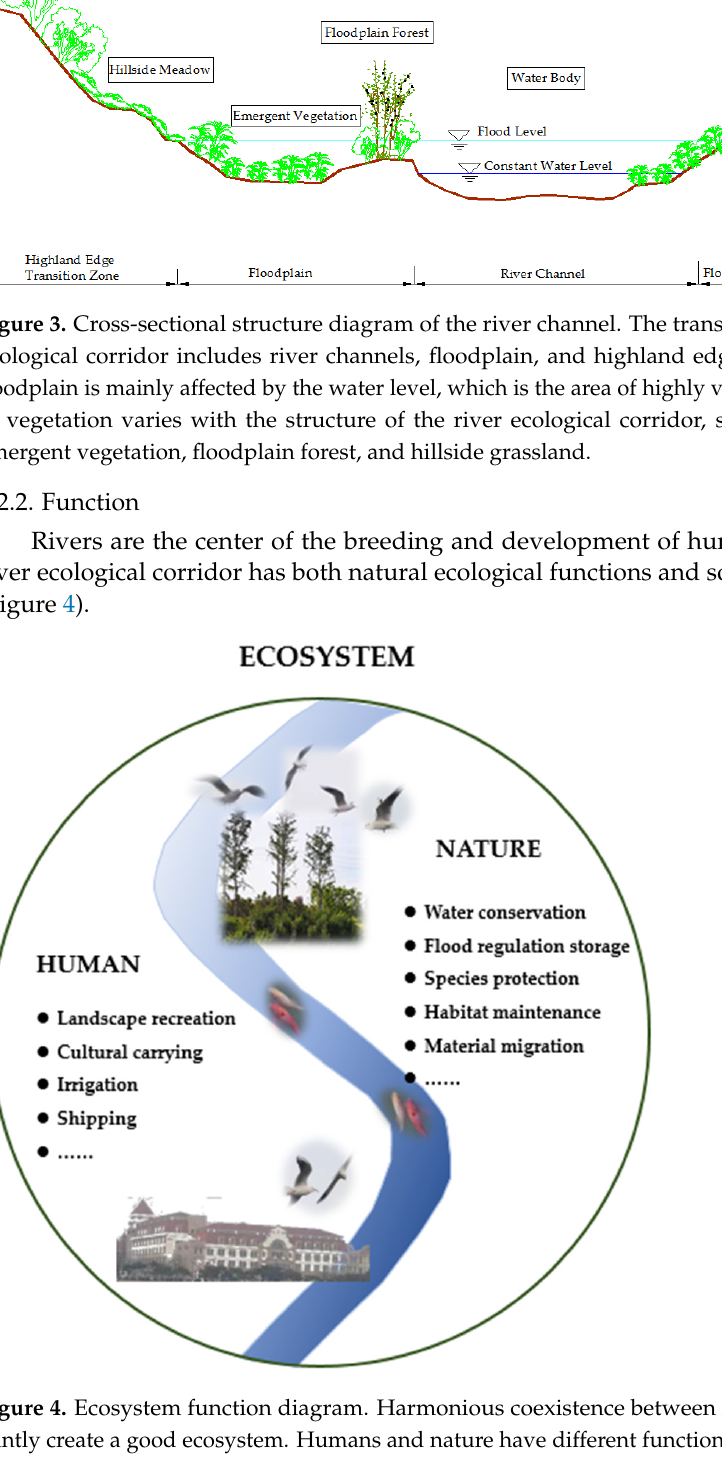
7 of 22 Figure 2. Four ‐ dimensional structure diagram of river ecological corridor [52] (Reproduced with permission from [Dong Z.R.], [Eco ‐ hydraulic Engineering]; published by [China Water Power Press], (2019)). The river ecological corridor includes the transversal dimension, the longitudinal dimension, the vertical dimension, and the time dimension. The transversal dimension includes a river channel, floodplain, and highland edge transition zone with typical spatiotemporal characteristics (Figure 3). These areas have different spatial ranges during the long ‐ term evolution of rivers. The floodplain is located on both sides or one side of the river channel and changes with flood inundation. The transition zone at the edge of the highland is the transition zone between the floodplain and the surrounding terrace [63–65]. In the longitudinal dimension, there are different